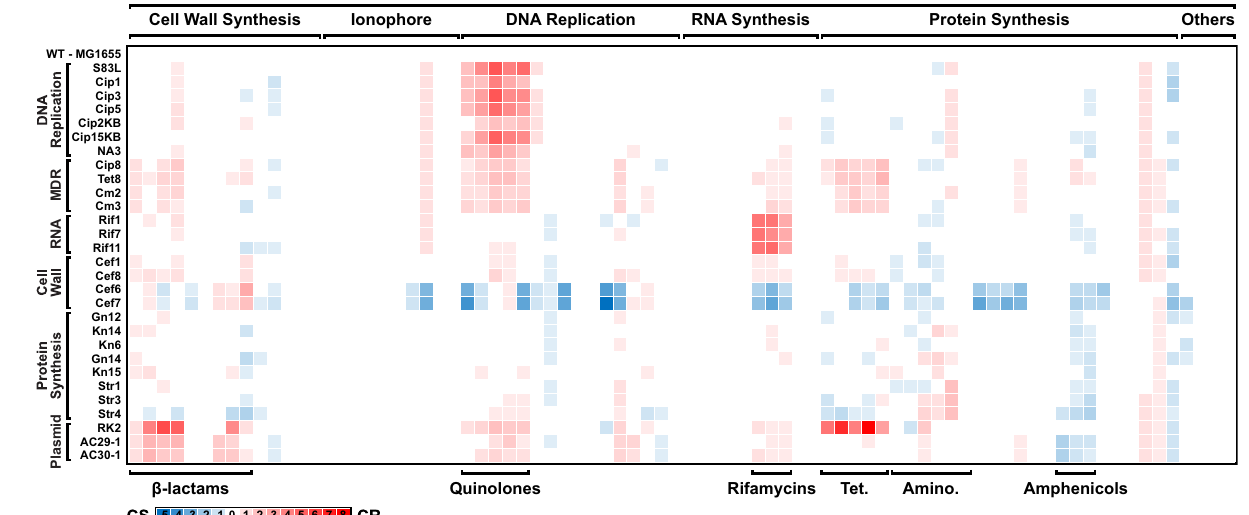
are categorized by their resistance mechanism (left). MDR multidrug resistance, RNA RNA synthesis, Cell Wall cell wall biosynthesis, Plasmid plasmid-borne multi- drug resistance, Tet. tetracyclines, Amino. aminoglycosides. Data shows the aver- age of three independent experiments ( n =3). For a fully annotated version of this fi gure see Supplementary Information Fig. 1. Source data are provided as a Source Data fi le.